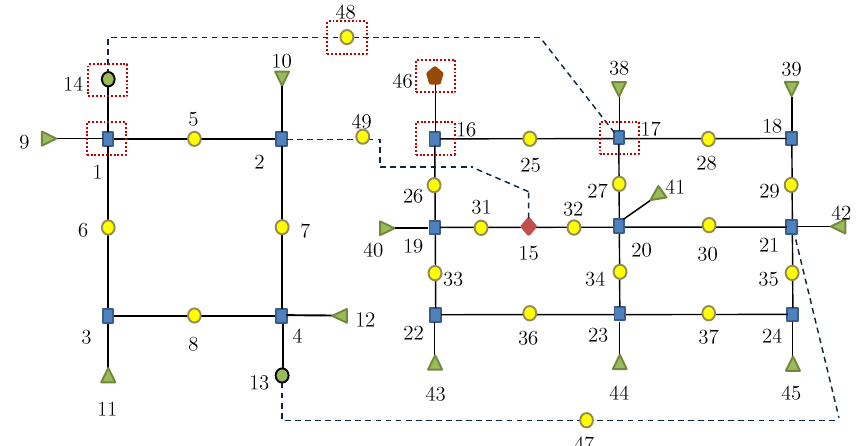
Figure 5. Scale-free coupled graph indicating the nodes that are excluded from